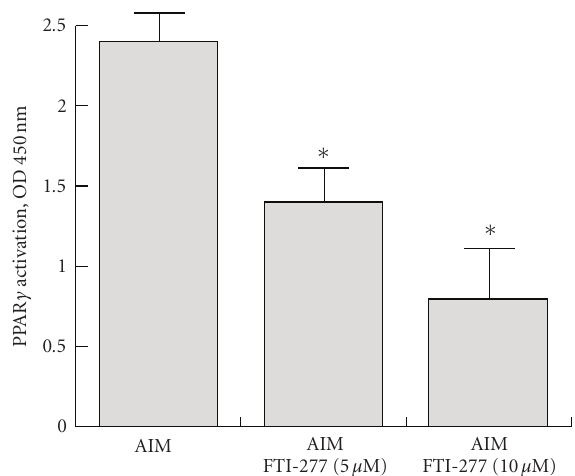
Figure 5: E ff ect of FTI-277 on PPAR γ 2 activity: PPAR γ DNA bind- ing activity was determined using ELISA-based PPAR γ activation kit and quantified by colorimetry. The levels of activity after treat- ment with either AIM or AIM + FTI-277 (5–10 μ M) are shown. Both dosages (5 and 10 μ M) significantly reduced the activity of the PPAR γ complex in the nuclei. Values are mean ± SEM of 6 wells per group in three independent experiments; ∗ P < .01 versus matched untreated